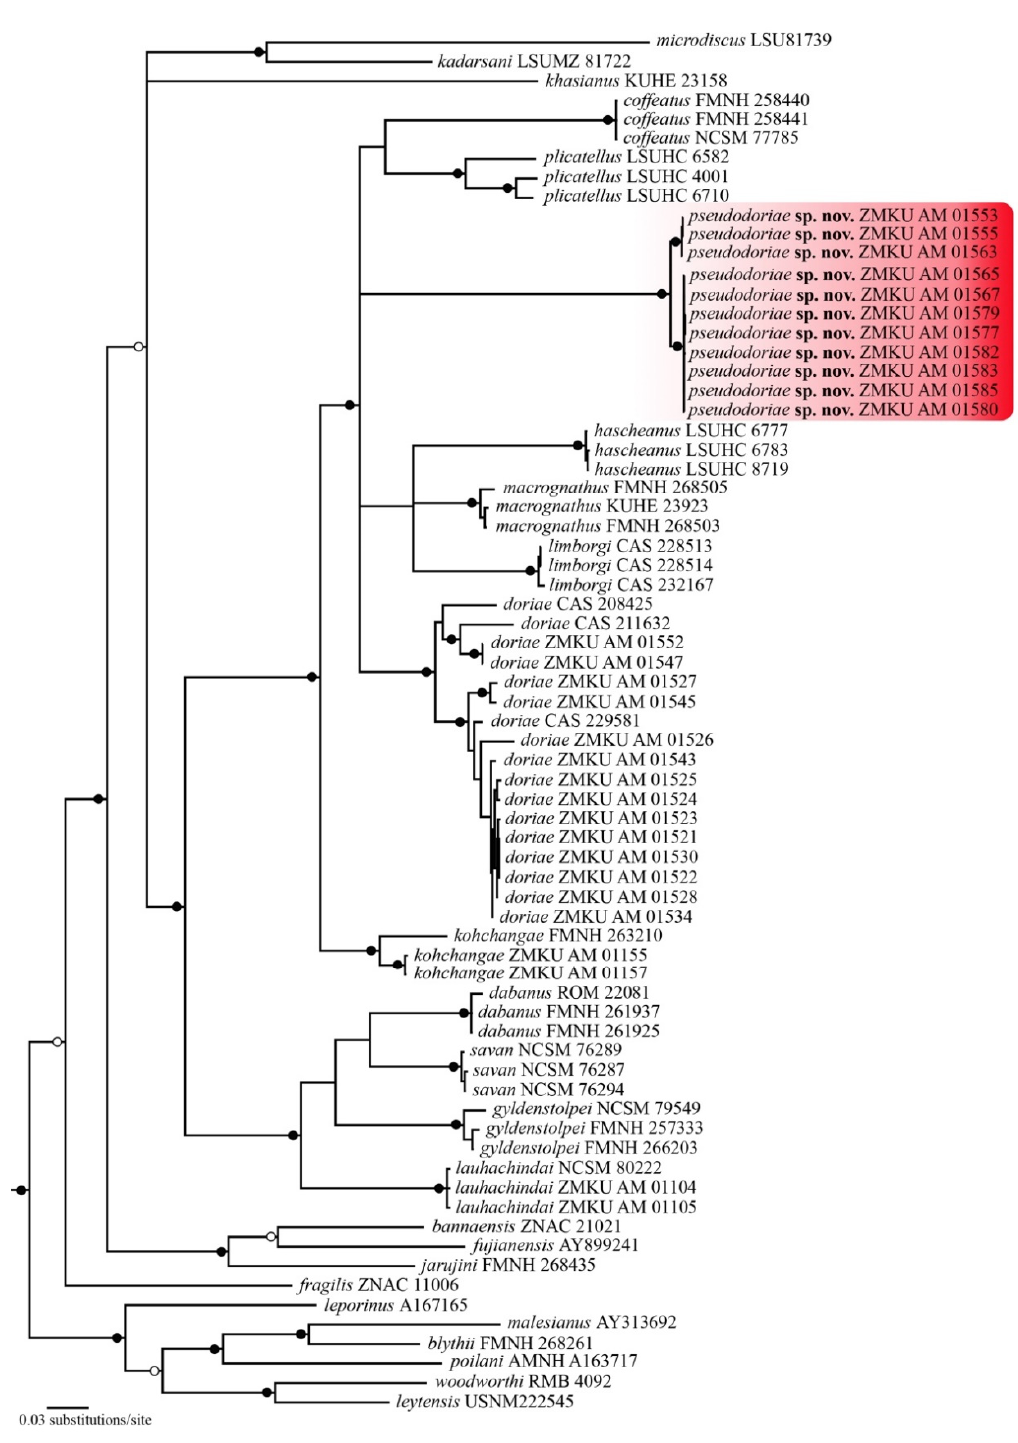
Figure 1. Fifty percent majority-rule consensus phylogram resulting from mixed-model Bayesian analysis of 2380 aligned characters of mitochondrial DNA from dicroglossid frogs in the genus Limnonectes . The outgroups Fejervarya limnocharis (NC_005055) and Quasipaa spinosa (NC_013270) were included in the analysis (not shown). Black circles at nodes indicate Bayesian posterior probabilities ≥ 0.99, and open circle at nodes indicate Bayesian posterior probabilities ≥ 0.95. Numbers at terminal tips are voucher numbers (except those for L. fujianensis and L. malesianus are GenBank accession numbers). GenBank accession numbers and locality data for sequenced samples are provided in Table S1.